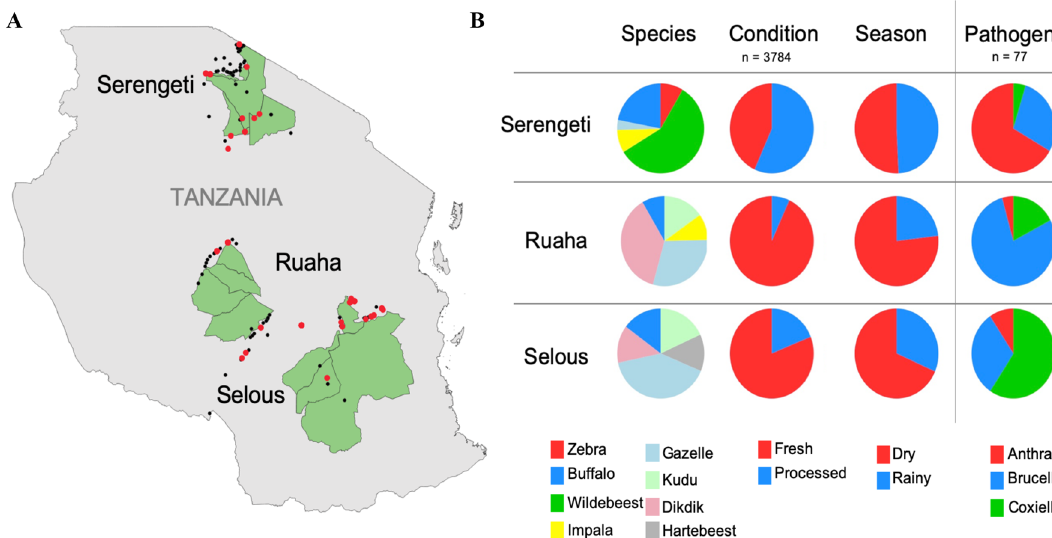
Figure 1. Map and distribution of bushmeat samples collected from the three ecosystems in Tanzania. ( A ) Map of the sample collection sites. In the map, the three regions are shown in green. The points show the distribution of samples collected (black circles) and samples positive for one of the three pathogens (red circles). ( B ) Distribution of the collected bushmeat samples. The pie charts show the stratification of the collected bushmeat samples. For the species category ( n = 3784), the top 5 most abundant species collected from the particular region are shown: Serengeti–Wildebeest (green), Buffalo (blue), Zebra (red), Impala (yellow), Gazelle (light blue); Ruaha–Dik-dik (pink), Gazelle (light blue), Kudu (light green), Impala (yellow), Buffalo (blue); Selous– Gazelle (light blue), Buffalo (blue), Dik-dik (pink), Kudu (light green), Hartebeest (grey). For the condition category ( n = 3784), the red represents fresh samples and blue represents processed samples. For the season category ( n = 3784), dry and rainy seasons are represented by the red and blue colors, respectively. The pathogen column ( n = 77) shows the proportion of each pathogen from each region with B. anthracis shown in red, Brucella in blue, and Coxiella in green. The samples were collected from both dry and rainy seasons, Ruaha (dry; I = 1297; rainy = 391), Selous (dry = 813; rainy = 374), Serengeti (dry = 461; rainy = 448), and from two sample conditions, Ruaha (fresh = 1571; processed = 117), Selous (fresh = 962; processed = 223), Serengeti (fresh = 393; processed = 516). The map was generated using the QGIS Geographic Information System software. "QGIS Development Team (2019). Open- Source Geospatial Foundation Project. Version 3.4.9-Madeira. http:// qgis. osgeo.